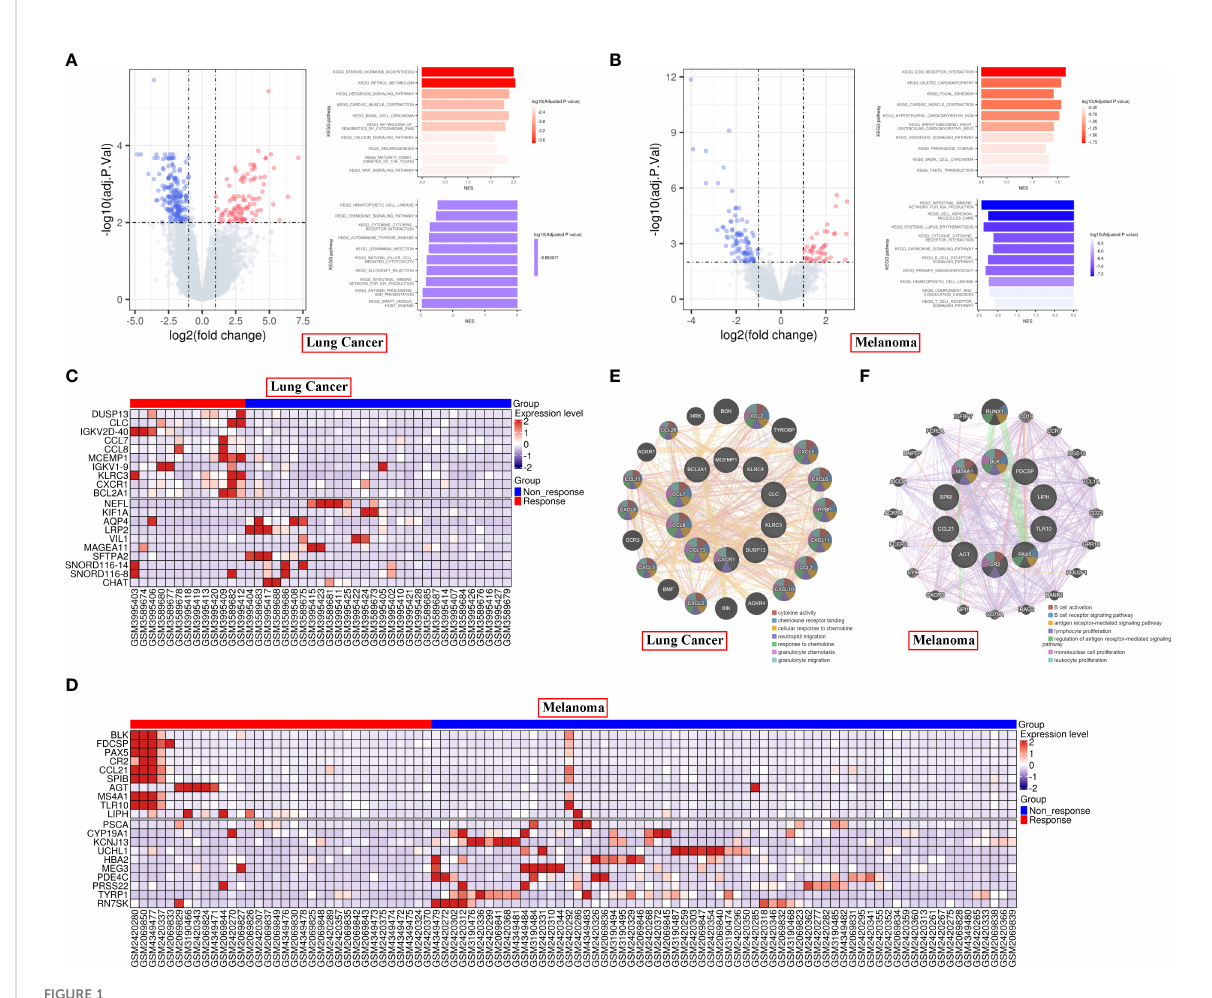
FIGURE 1 Differential gene expression in responder vs non-responder patients with lung cancer or melanoma. (A, B) Volcano plot and KEGG pathways of the DEGs in lung cancer (A) and melanoma (B) . (C, D) Heatmap of the top 10 signi fi cantly upregulated or downregulated genes in lung cancer (C) and melanoma (D) . (E, F) PPI analysis of the top 10 upregulated protein-coding genes in lung cancer (E) and melanoma (F)